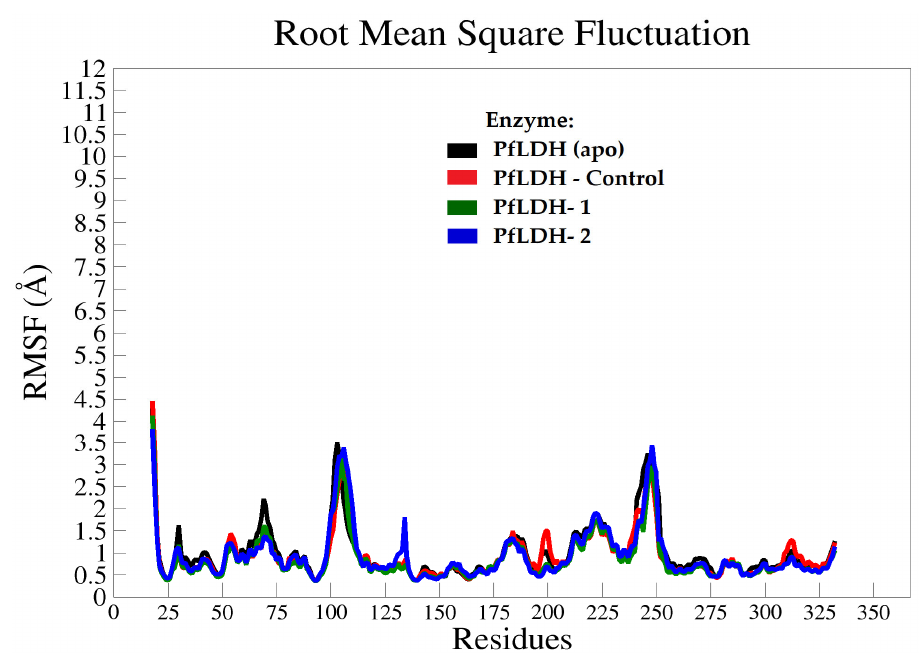
Figure 4. The RMSF graphs of the Pf LDH backbone atoms throughout the 100 ns MD simulation time for all systems. The RMSF values indicate the residual atomic fluctuations of each amino acid residue when they interact with the ligands throughout the trajectory.